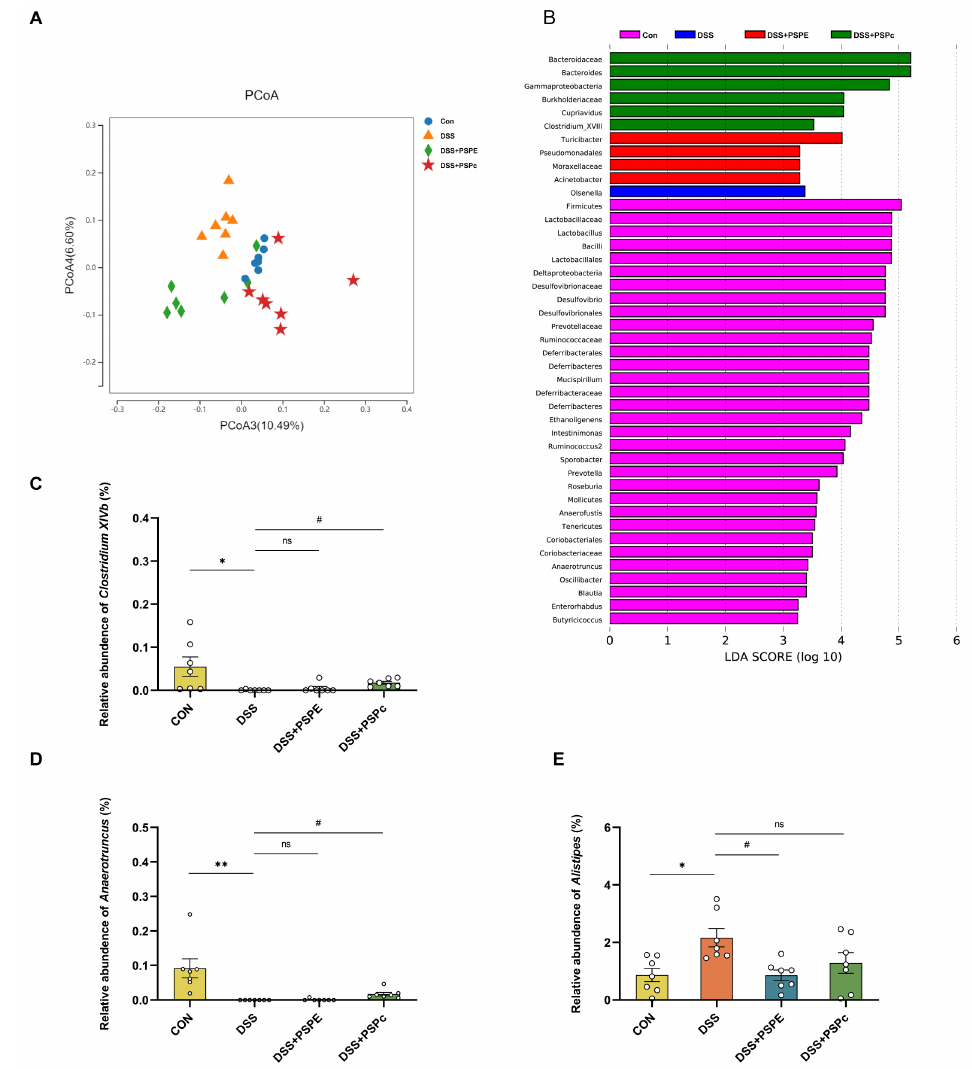
Figure 5. Effect of PSPE and PSPc on the gut microbiome compositions in DSS-induced colitis mice. ( A ) Principal components analysis (PCoA); ( B ) linear discriminant snalysis (LDA) score. ( C ) Relative abundance (%) of Clostridium XlVb ; ( D ) relative abundance (%) of Anaerotruncus ; ( E ) relative abun- dance (%) of Alistipes ; data are presented as mean ± SE, and statistical significance was determined by Kruskal–Wallis test (H test) with, n = 7 mice. * p < 0.05, ** p < 0.01, compared with the Con group, # p < 0.05, compared with the DSS group, ns = not